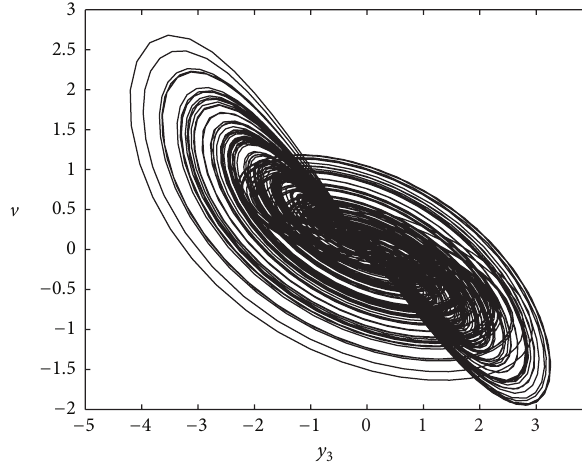
Figure 4: 𝑦 2 - 𝑦 3 phase plane, the chaotic attractor.